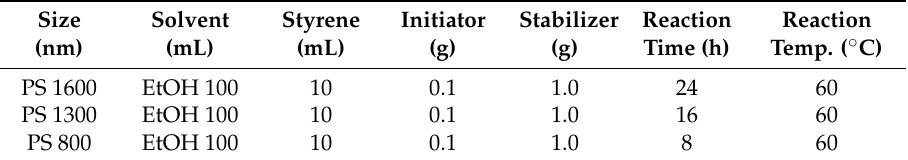
Table 1. Polymerization conditions for the obtention of PS